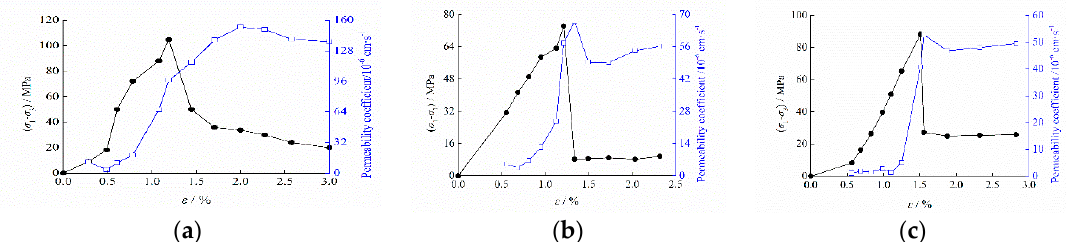
Figure 2. Relation between servo-controlled and stress permeability under saturated condition [29]; ( a ) Limestone; ( b ) Fine sandstone; ( c ) Medium sandstone.